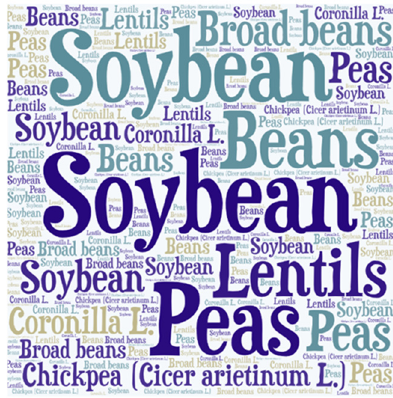
Figure 1. Word cloud—pulses preferences in the shopping cart one week before the survey. Note: A word cloud based on associations with legumes. The associations are based on the first 3 answers to the question: “What kind of pulses do I buy for preparing meals”. The more duplications there were, the bigger the word and the part is presented in the cloud. Source: Authors’ own results.